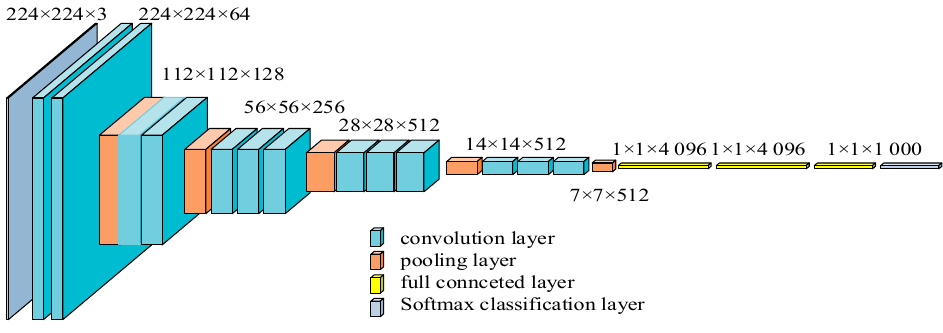
Figure 8. VGG16 network structure . The VGG16 network structure consists of 13 convolutional layers and three fully con- nected layers for 16 weight layers. The input part of VGG16 is a 224 × 224 × 3 RGB image. After processing the entire convolutional network, the output structure is the probability that the input image belongs to each category. The model is divided into six parts overall.